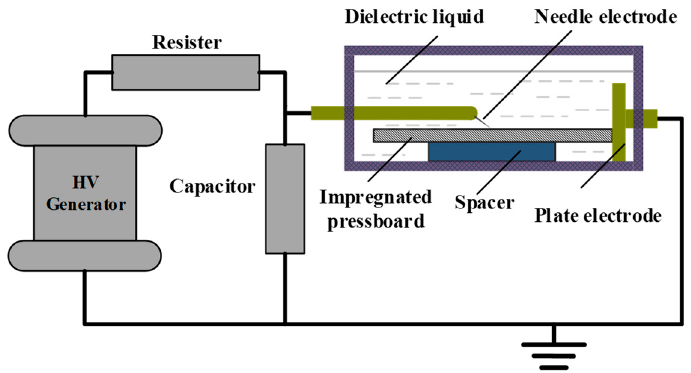
Figure 2. Experimental setup for creeping flashover tests.